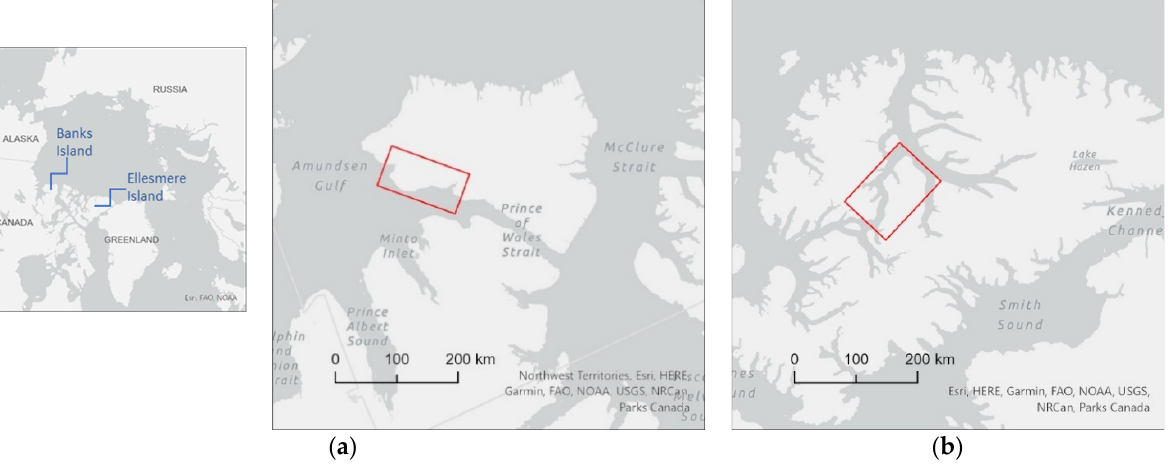
Figure 1. Inset map shows the geographical setting of the study area. Enlarged views shown in ( a , b ) depict the areas of interest from Banks Island and the Eureka Sound Lowlands (Axel Heiberg and Ellesmere Islands), respectively. The red hollow box shows the total area mapped using the UNet deep learning model.